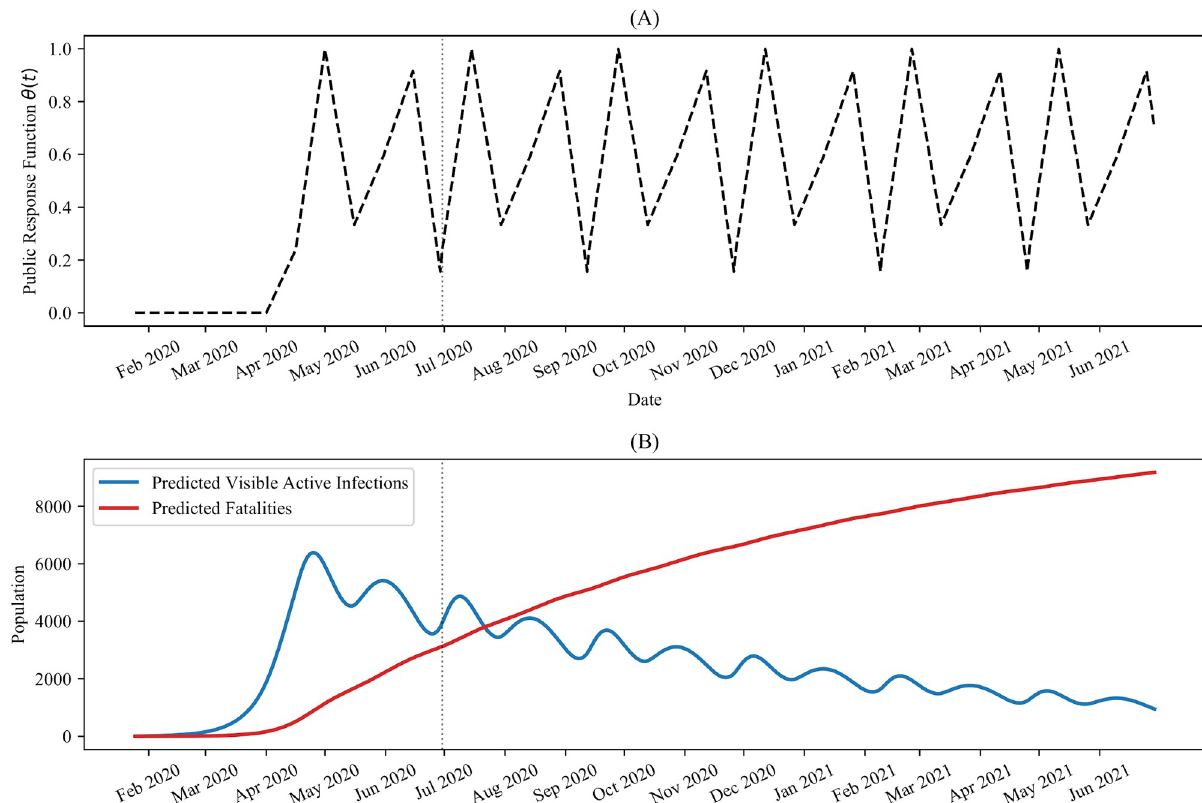
Fig 6. Predicted pandemic progression for periodic public-response. Predicted future pandemic progression, obtained by maintaining the in Fig 3. (A) The chosen θ ( t ) schedule, showing periodic oscillations for t > t periodicity in the functional form of θ , observed for t � t n corresponding active visible infections and fatalities, predicted by the Distancing-SEIRD model with the parameter values in Table 1. In both plots, the dotted vertical line indicates τ 7 = t = June 30, 2020. n